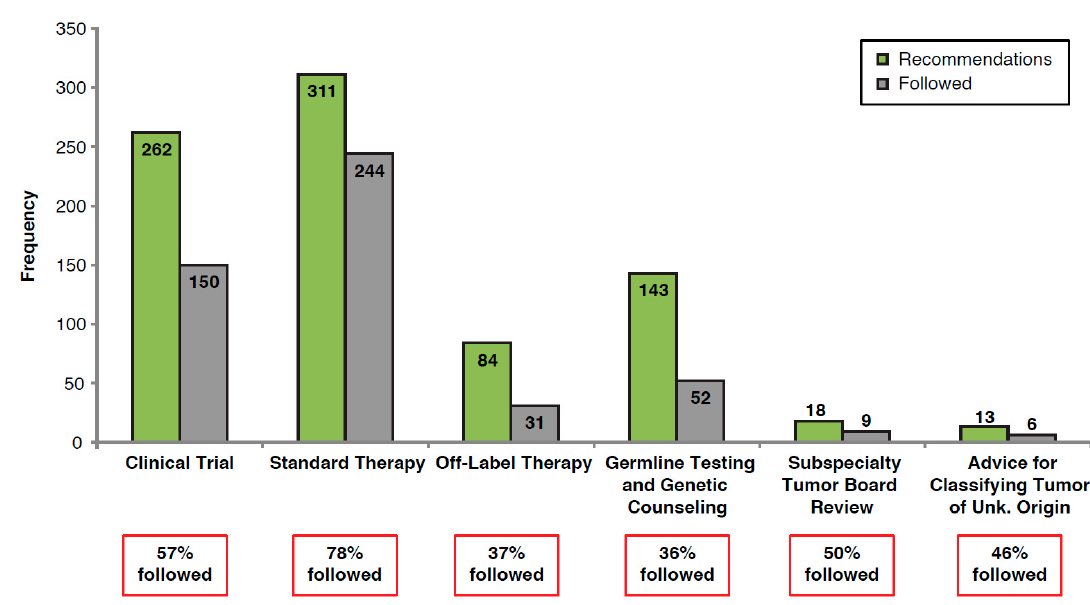
Figure 2. Proportion of MTB recommendations followed by the treating physician for all patients. MTB, molecular tumor board.